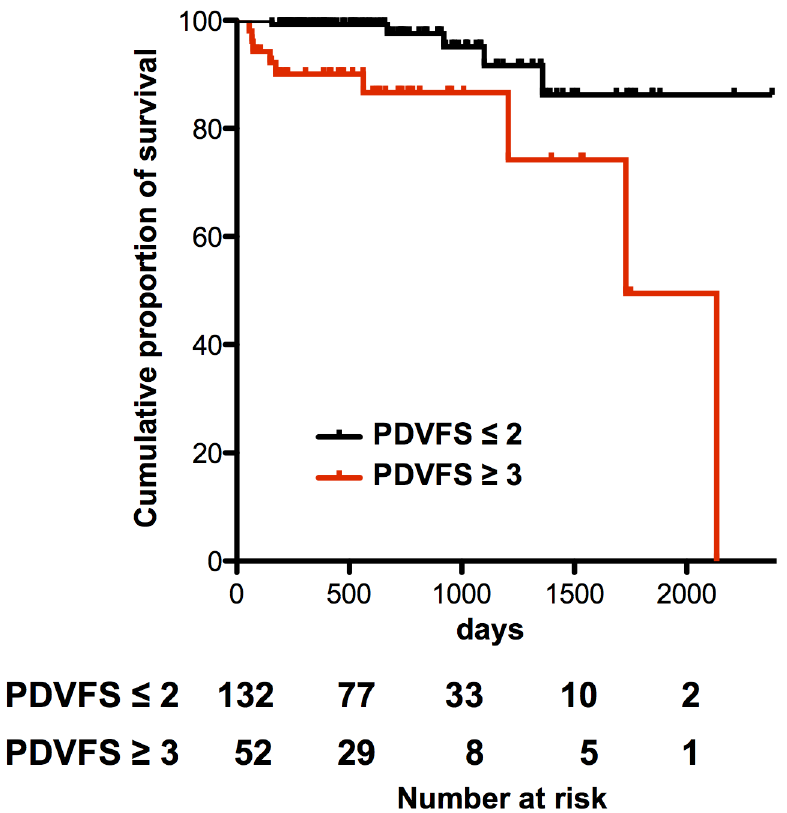
Fig 3. Cumulative survival rates according to PDVFS score ( (cid:20) 2 vs . (cid:21) 3). There was statistically significant difference in the survival rate (Log rank P = 0.001).